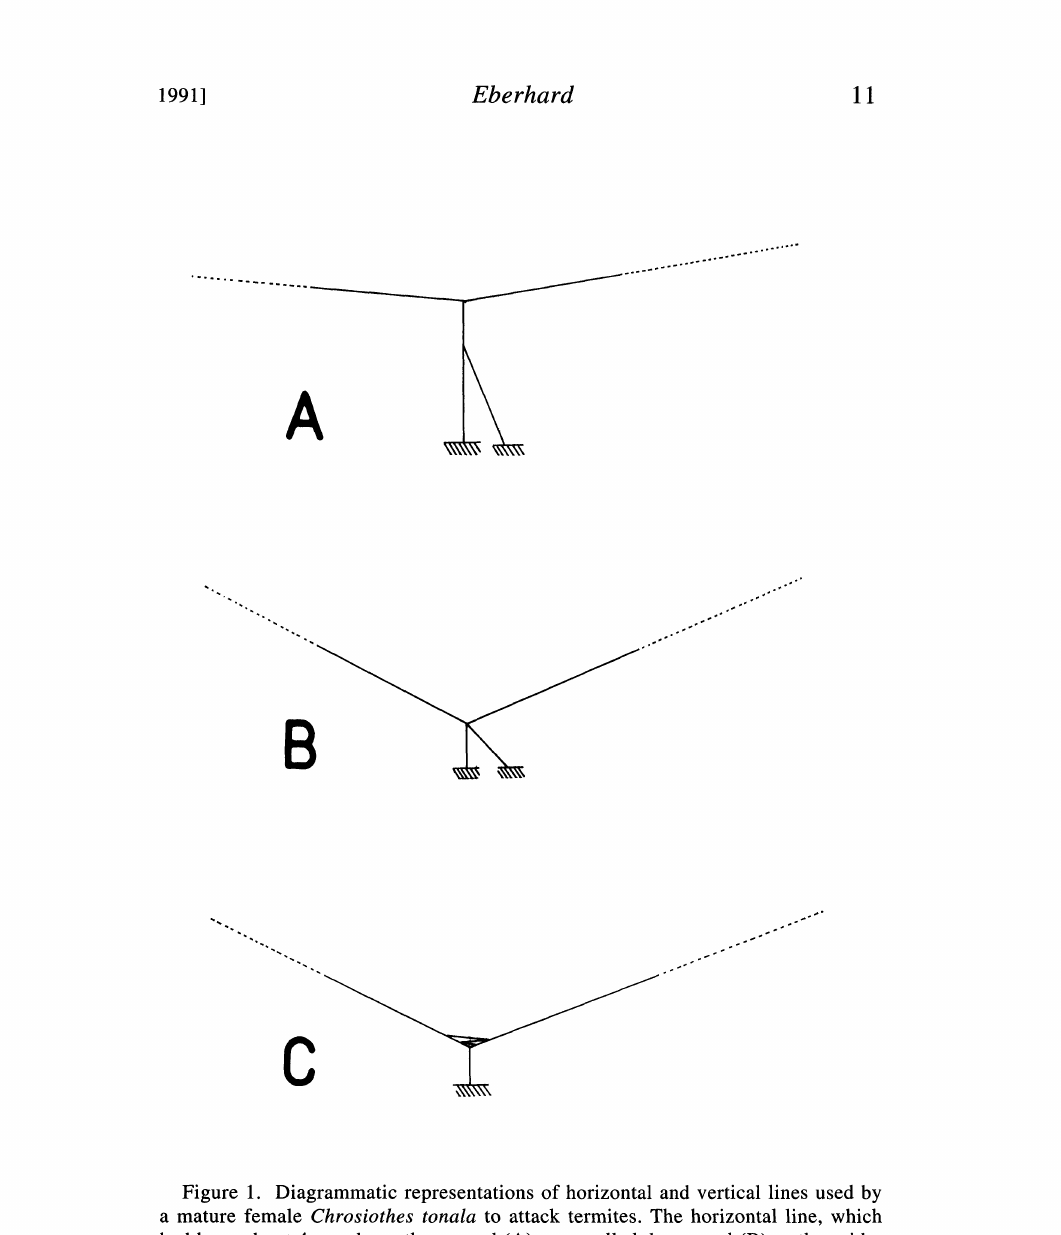
Figure 1. Diagrammatic representations of horizontal and vertical lines used by a mature female Chrosiothes tonala to attack termites. The horizontal line, which had been about 4 cm above the ground (A), was pulled downward (B) as the spider made its first attack descent. On the trip upward after capturing the first termite the spider made zig-zag attachments to the horizontal line (C), which probably resulted in the line becoming